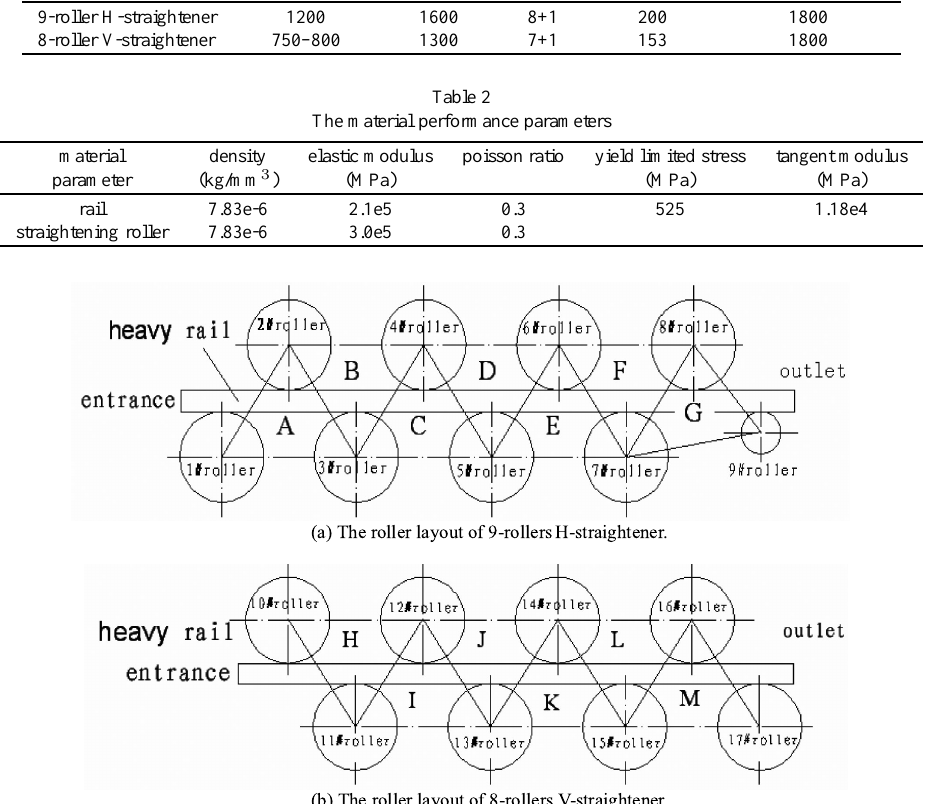
Fig. 2. The layout of rail compound